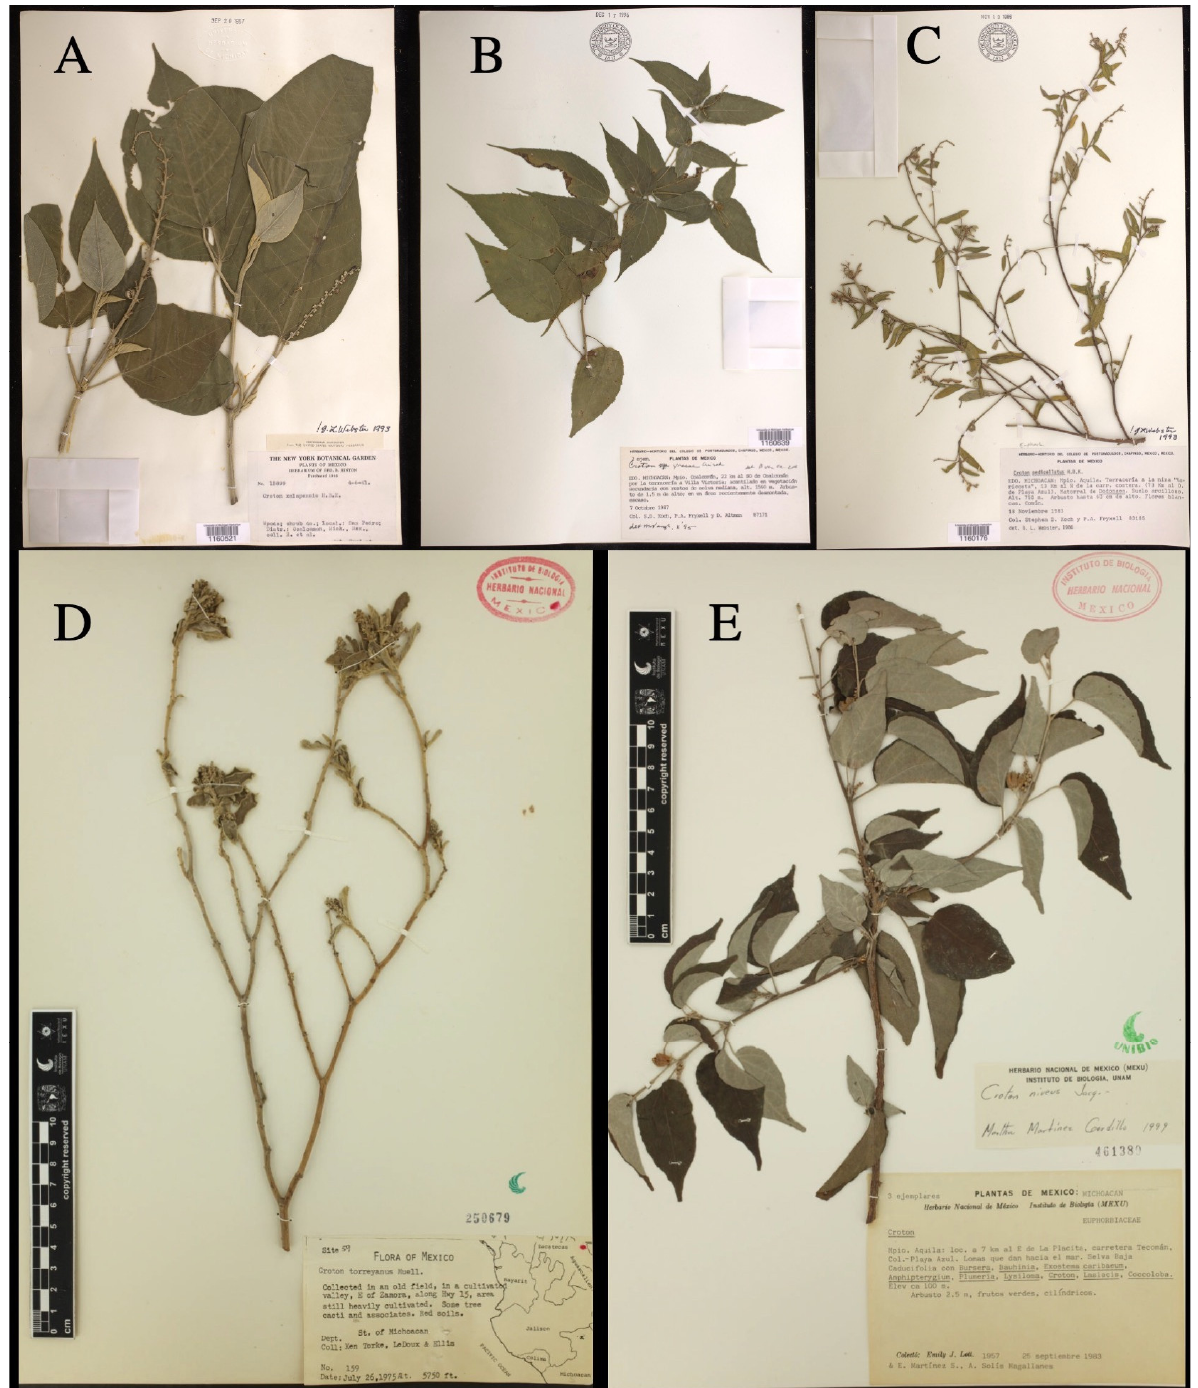
Figure A16. Herbarium specimens from the University of Michigan Herbarium (MICH) website (quod.lib.umich.edu/h/ herb00ic): ( A ) Croton xalapensis . ( B ) Croton ynesae . ( C ). Croton tenuilobus ; Herbarium specimens from the Universidad Nacional Aut ó noma de M é xico Herbarium (MEXU) website (datosabiertos.unam.mx/biodiversidad/): ( D ) Croton incanus . ( E ) Croton niveus